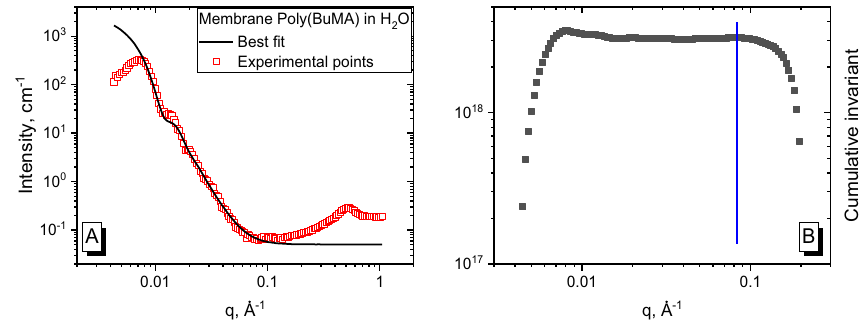
Figure 7. (A) Small-angle X-ray scattering curves of poly(BuMA) membranes in water with its best fit and (B) cumulative invariant with the labeled q max value as a vertical blue